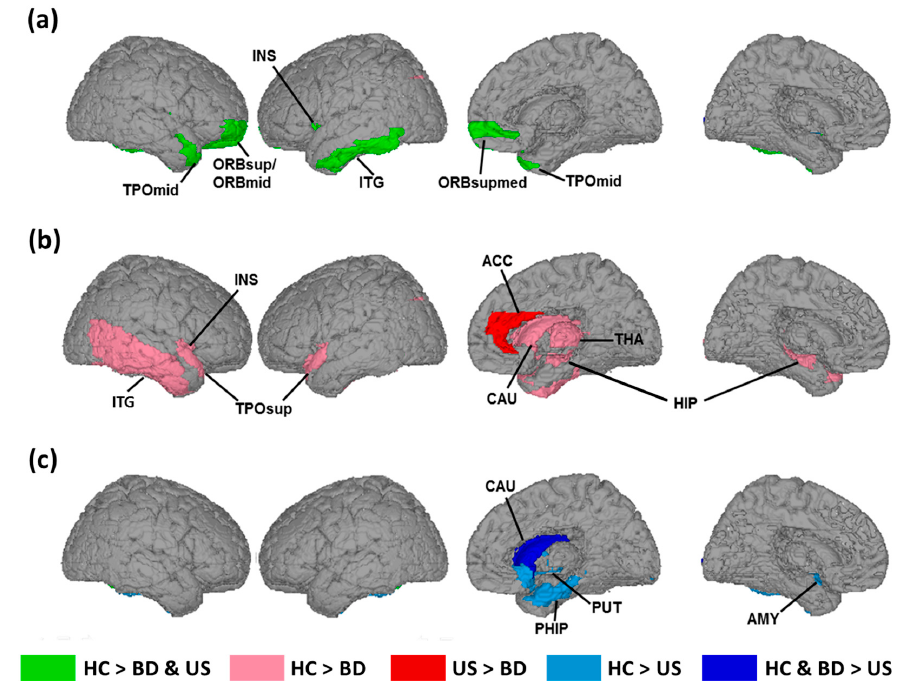
Figure 2. A summarized diagram of brain regions, with significant di ff erences in CVD values between BD patients, una ff ected siblings, and healthy controls. ( a ) Significant di ff erences in both BD patients and una ff ected siblings, compared with healthy controls; ( b ) significant di ff erences in BD patients compared with healthy controls and una ff ected siblings; ( c ) significant di ff erences in una ff ected siblings, compared with healthy controls and BD patients. HC: healthy controls; BD: bipolar disorder; US: una ff ected siblings; ORBsup: superior orbital frontal gyrus; ORBmid: middle orbital frontal gyrus; ORBsupmed: superior-medial orbital frontal gyrus; TPOsup: superior temporal pole; TPOmid: middle temporal pole; ITG: inferior temporal gyrus; ACC: anterior cingulate cortex; INS: insula; HIP: hippocampus; PHIP: parahippocampal gyrus; CAU: caudate; PUT: putamen; THA: thalamus; AMY: